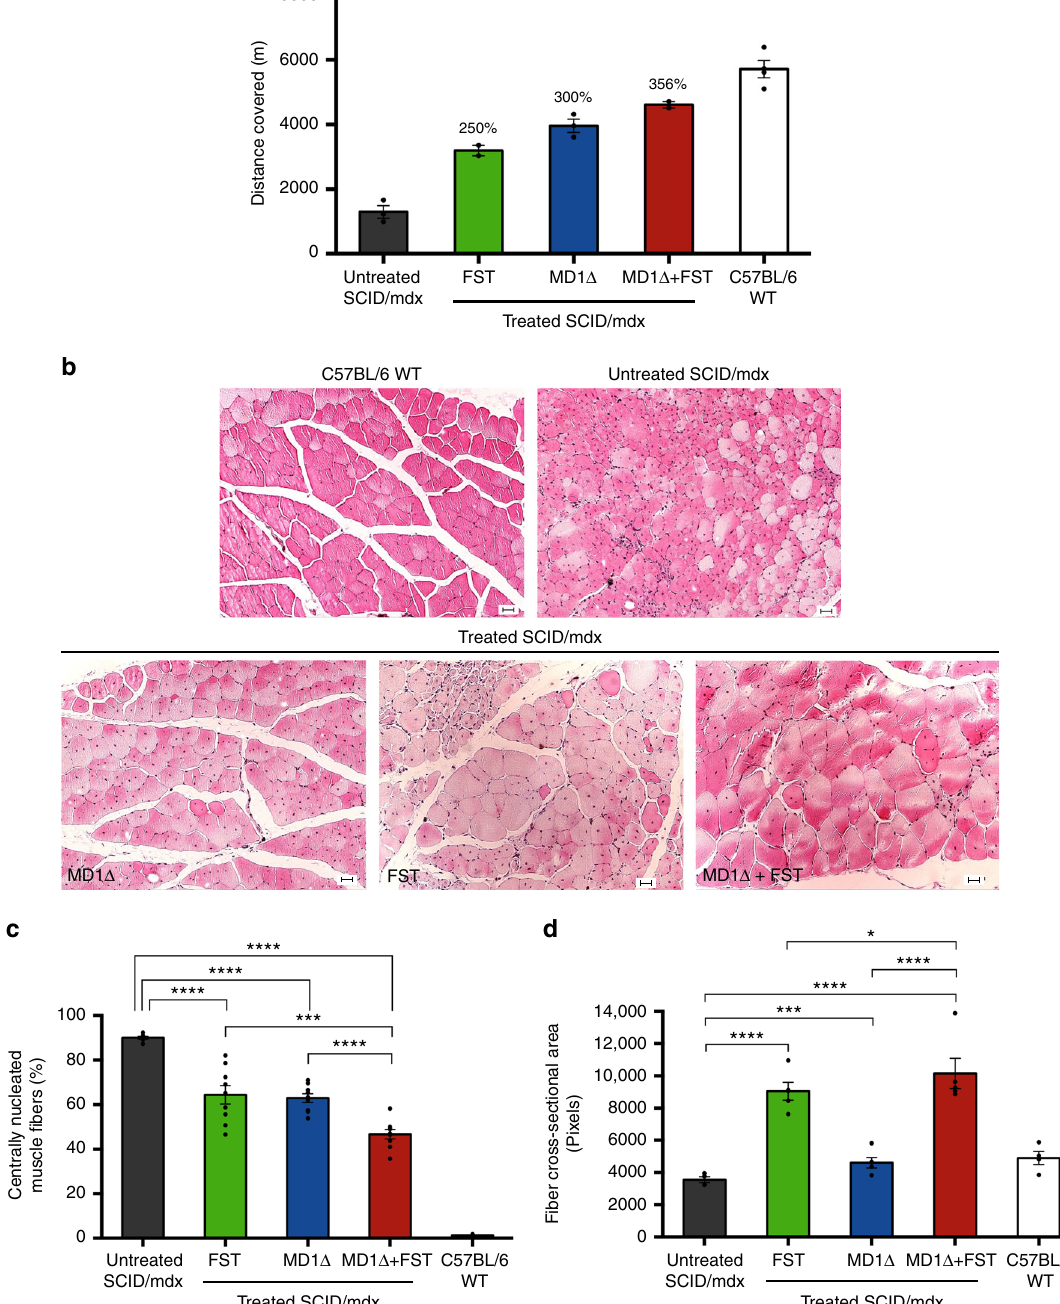
Fig. 6 Phenotypic correction of muscular dystrophy in SCID/mdx mice. a SCID/mdx mice injected with ssAAV9-Sk-CRM4-Des-MD1 Δ only, ssAAV9-Sk- CRM4-Des-FST only, and ssAAV9-Sk-CRM4-Des-MD1 Δ with ssAAV9-Sk-CRM4-Des-FST combination therapy (2 × 10 10 vg/mouse of each vector) were subjected to a treadmill assay. Physical performance of the 20-week-old SCID/mdx mice treated with the different therapeutic vectors compared to the untreated age-matched control SCID/mdx mice was determined by measuring the distance covered. Results were presented as mean ± standard error of the mean, (% increase in distance covered relative to untreated SCID/mdx was indicated. b – d Improvement of pathophysiological properties in SCID/mdx mice injected with ssAAV9-Sk-CRM4-Des-MD1 Δ , ssAAV9-Sk-CRM4-Des-FST, ssAAV9-Sk-CRM4-Des-MD1 Δ , and ssAAV9-Sk-CRM4-Des-FST combination therapy. b Hematoxylin and eosin staining of 5 μ m thick transverse sections of the tibialis anterior muscle from mice treated with the different therapeutic vectors were compared with those of age-matched control C57BL/6 and SCID/mdx mice treated with PBS. The scale bars indicate 50 μ m. c Graphical representation of the % of central nucleation in muscle fi bers from treated sections versus the age-matched non-treated sections. Results were presented as mean ± standard error of the mean, *** p < 0.001 and **** p < 0.0001 using Student ’ s t -test ( n = 4 – 9). d Muscle fi ber cross-sectional area (expressed in pixels) of each of the different groups of SCID/mdx mice treated with the different therapeutic vectors (at a dose of 2 × 10 10 vg/mouse). Untreated SCID/mdx and C57BL/6 mice were used as controls. Results were presented as mean ± standard error of the mean, * p < 0.05; *** p < 0.001, and **** p < 0.0001 using Student ’ s t -test ( n = 4 –